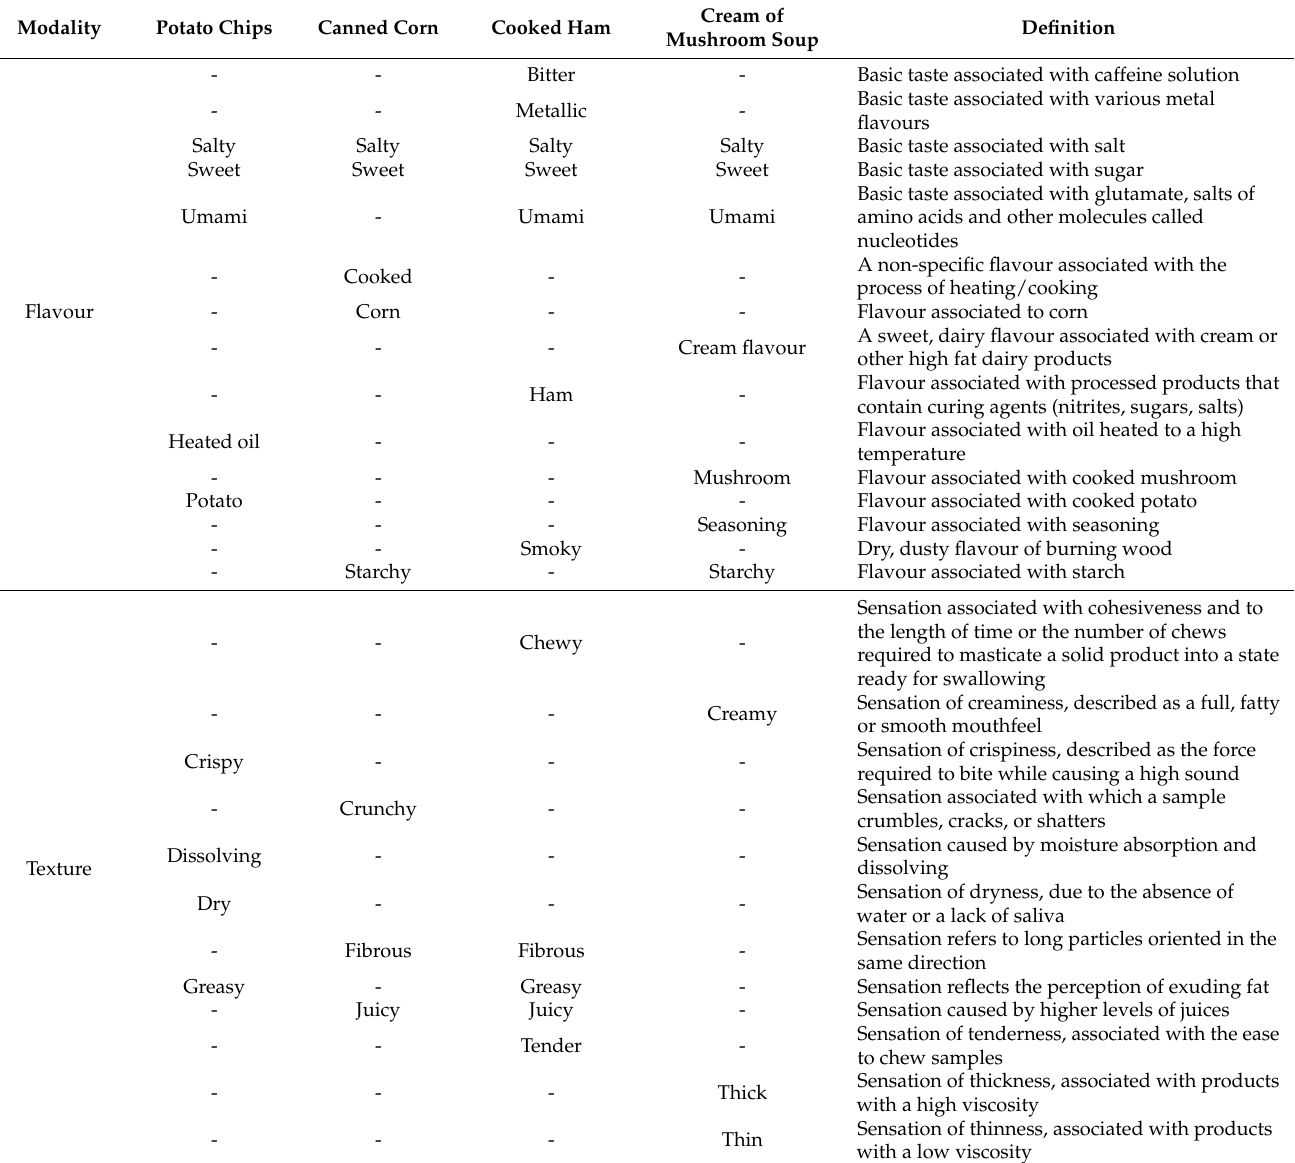
Table 2. Sensory attributes and definitions used in TDS and TCATA evaluations of potato chips, canned corn, cooked ham and cream of mushroom soup. An attribute list was prepared for each